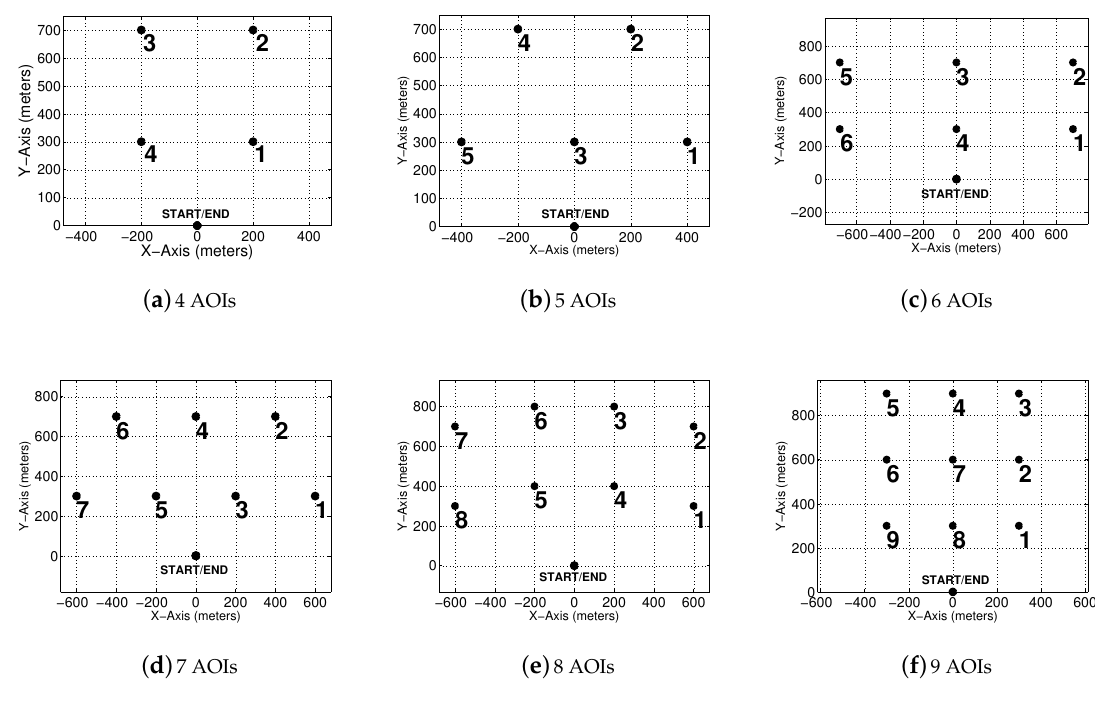
Figure 13. Simulation